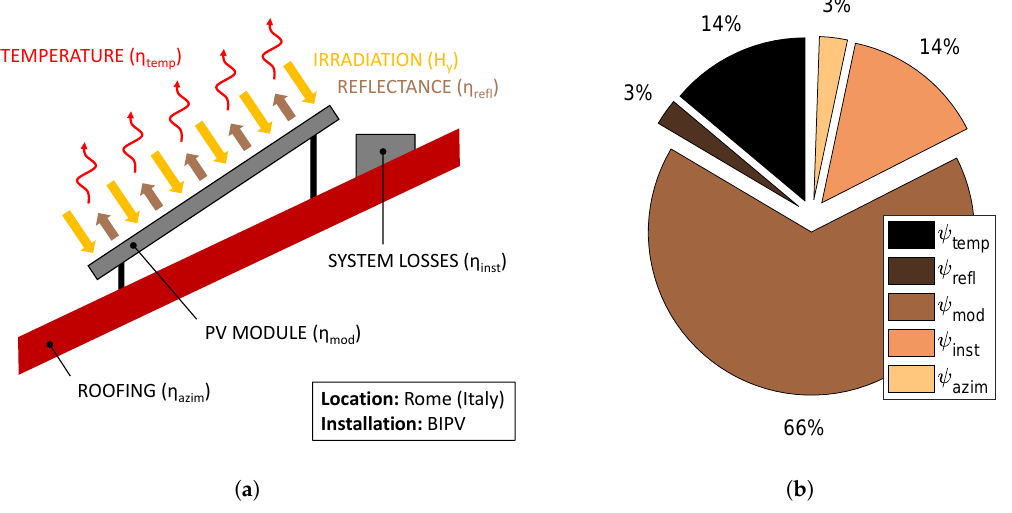
Figure 8. ( a ) Sample analysis of the various contributions to the total losses ( η = 1 − ψ ) for a building-integrated installation (BIPV) in the city of Rome (Italy) with unitary exposed surface. The azimuthal angle considered is α z = 35 ◦ ( ψ azim losses), the module efficiency is η mod = 0.25 ( ψ mod losses) for crystalline silicon solar cells [50], and the installation efficiency is η inst = 0.84 ( ψ inst losses). ( b ) The results obtained show that the main contribution to the total losses depends on the choice of the module